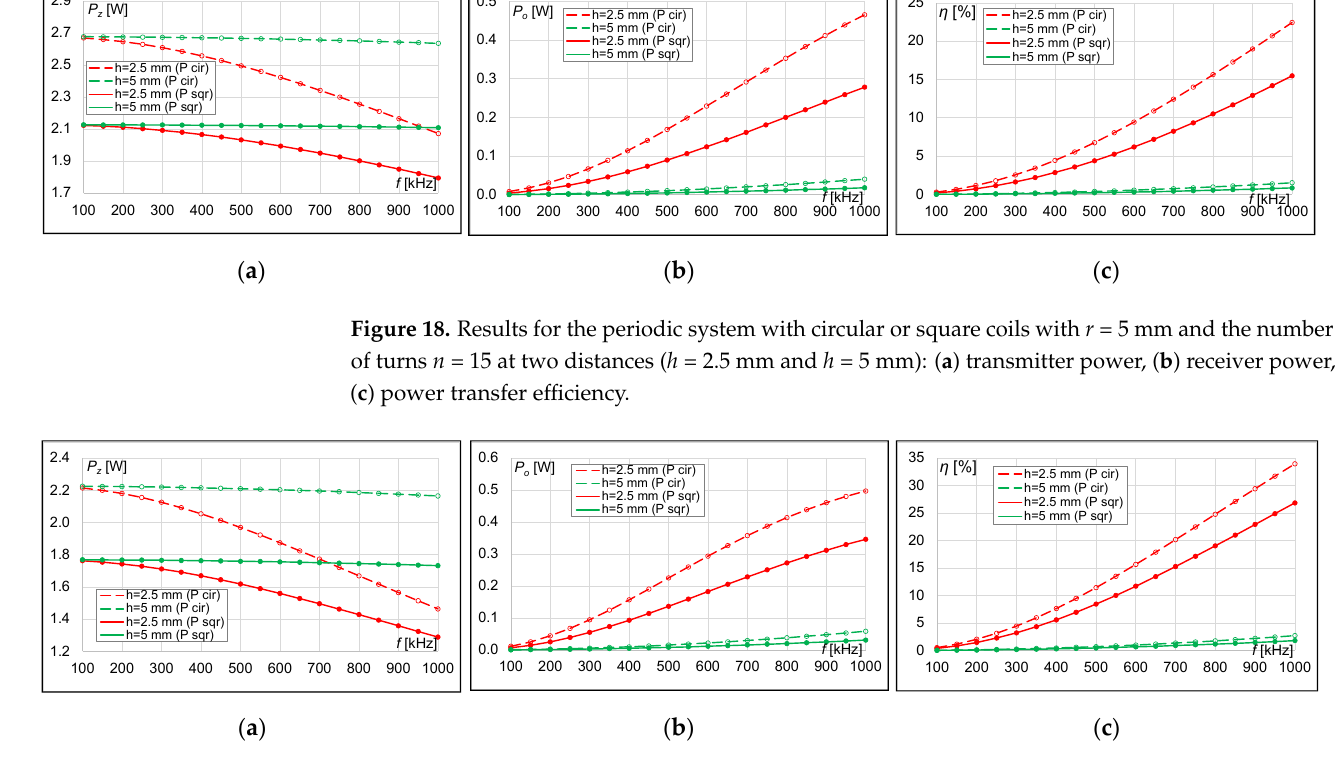
Figure 19. Results for the periodic system with circular or square coils with r = 5 mm and the number of turns n = 20 at two distances ( h = 2.5 mm and h = 5 mm): ( a ) transmitter power, ( b ) receiver power, ( c ) power transfer efficiency.